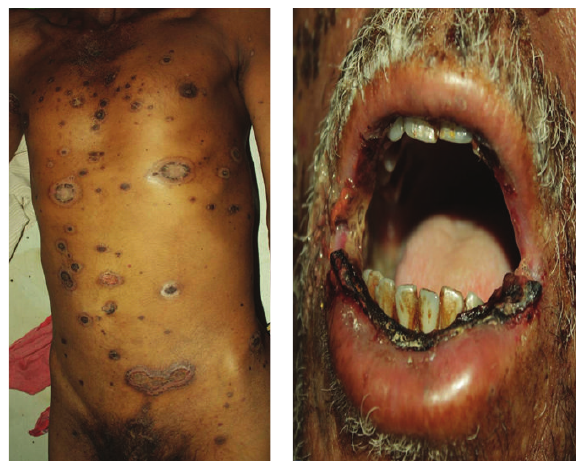
Figure 1: Ulceration over psoriatic lesions with crusting on lips (Case 1).